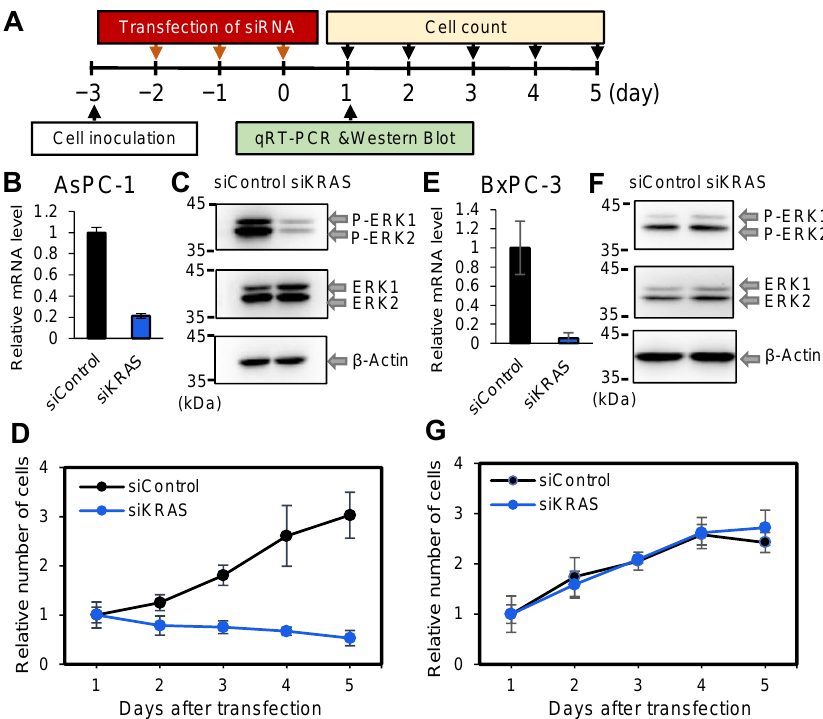
Figure 1. Effects of siKRAS on the endogenous KRAS mRNA expression, KRAS signaling, and numbers of AsPC-1 and BxPC-3 cells. ( A ) Experimental procedure used to investigate the effects of siKRAS on AsPC-1 and BxPC-3 cells. ( B ) KRAS mRNA levels quantified by qRT-PCR in AsPC-1 cells on day 1 after three transfections of siControl or siKRAS at 50 nM. The result for siControl was set to 1, and KRAS mRNA level relative to siControl is shown. The results indicate the averages of 3 independent experiments. ( C ) Western blotting using lysates of AsPC-1 cells transfected with siControl or siKRAS. Unphosphorylated ERK1/2 (ERK1/2) and phosphorylated ERK1/2 (P-ERK1/2) were detected by anti-ERK1/2 and anti-phospho- ERK1/2 antibodies, respectively; β -actin was used as a control. ( D ) Number of AsPC-1 cells relative to those on day 1 after three transfections of siCon- trol or siKRAS. The black line indicates the number of AsPC-1 cells transfected with siControl, and the blue line indicates the number of cells transfected with siKRAS. The results indicate the averages of 3 independent experiments. ( E ) KRAS mRNA levels quantified by qRT-PCR in BxPC-3 cells on day 1 after three transfections of siControl or siKRAS transfections at 50 nM. The results indicate the averages of 3 independent experiments. ( F ) Western blotting using lysates of BxPC-3 cells trans- fected with siControl or siKRAS. ( G ) Relative number of BxPC-3 cells from 1 day after three trans- fections of siControl or siKRAS. The black line indicates the number of BxPC-3 cells transfected with siControl, and the blue line indicates the number of cells transfected with siKRAS. The results indi- cate the averages of 3 independent experiments.